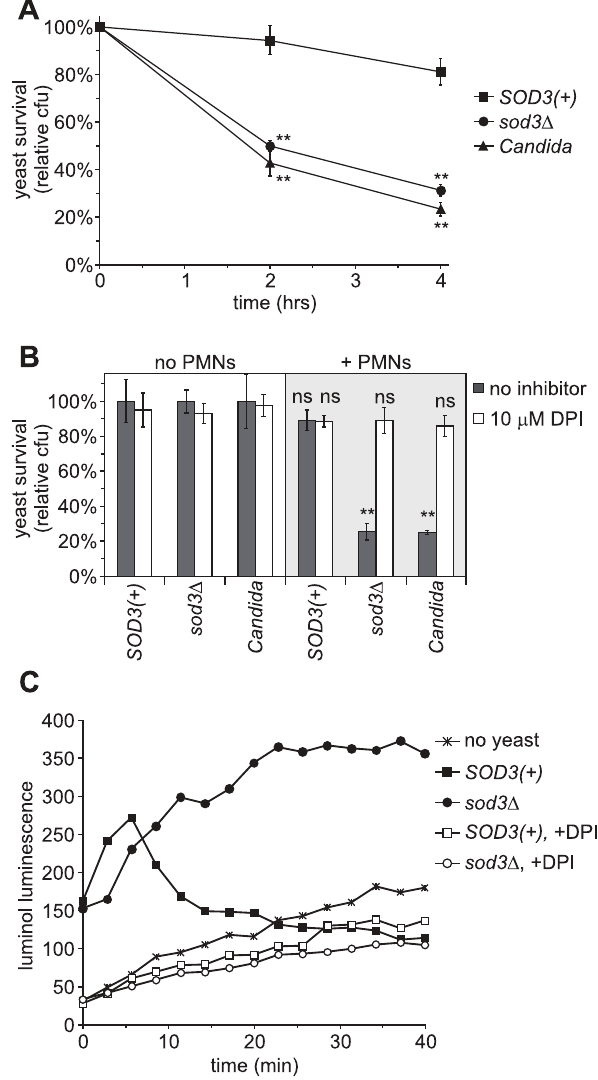
Figure 5. Sod3 protects Histoplasma yeasts from PMN-derived reactive oxygen. ( A ) Survival of yeasts after infection of human PMNs. SOD3( + ) (OSU45), sod3 D (OSU15) and Candida albicans yeasts were added to PMNs at a multiplicity of infection (MOI) of 1:10. Yeast survival was determined by enumeration of viable cfu after 2 and 4 hours of co- incubation of yeasts with PMNs at 37 u C. Results are plotted as relative yeast survival (mean 6 standard deviation of 3 replicates) compared to viable cfu of yeasts incubated in the absence of PMNs. Significantly decreased survival compared to SOD3( + ) yeasts is indicated by asterisks (** p , 0.01). ( B ) Inhibition of yeast killing by PMNs upon inactivation of the NADPH-oxidase. Yeasts were added to PMNs ( + PMNs) and incubated for 4 hours at 37 u C and viable cfu were determined. 10 m M diphenylene iodinium (DPI) was added to some assays to inactivate the NADPH- oxidase. Results indicate relative yeast survival (mean 6 standard deviation of 3 replicates) compared to viable cfu of yeast incubated in the absence of PMNs (no PMNs). Significant (** p , 0.01) or non- significant (ns) reduction in survival compared to yeast in the absence of PMNs is indicated above the respective columns. ( C ) Reactive oxygen production by PMNs in response to Histoplasma yeasts. Histoplasma yeasts were added to PMNs at an MOI of 1:1 in the presence of the luminol ROS-detection reagent and the luminol luminescence measured over time. PMNs and yeasts were co-incubated in the presence (open symbols) or absence (closed symbols)of 10 m M DPI to inhibit theNADPH- oxidase. Data points represent the mean luminescence